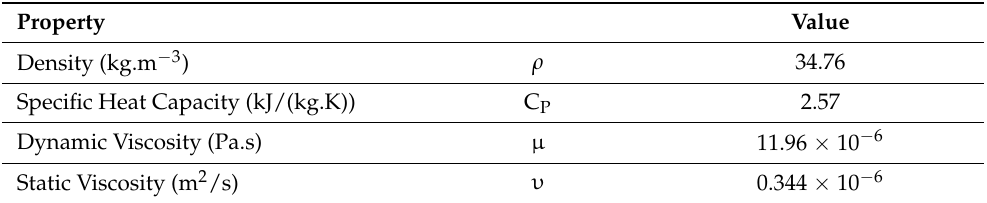
Table 2. The thermophysical properties of methane at T = 20 ◦ C and P = 700 psi (4826.33 kPa)